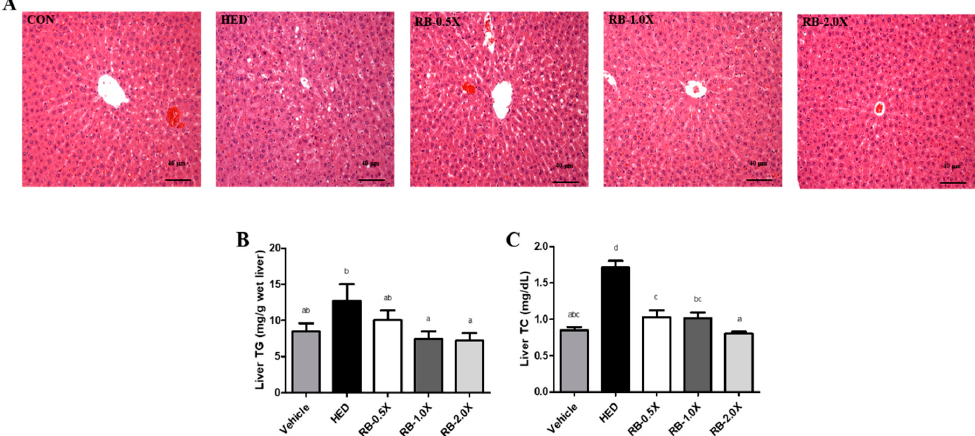
Figure 1. Effect of rice bran (RB) on the hepatic lipid accumulation in rats with high-energy diet (HED)-induced obesity. ( A ) Hematoxylin and eosin staining of liver sections (100× magnification). Scale bar: 40 μ m. ( B ) Liver triglyceride (TG) concentration and ( C ) liver total cholesterol (TC) concentration. The x-axis parameters are as follows: Vehicle, SD rat fed with chow diet; HED, SD rat fed with HED; RB-0.5X, SD rat fed with HED and RB-0.5X; RB-1.0X, SD rat fed with HED and RB-1.0X; and RB-2.0X, SD rat fed with HED and RB-2.0X. The data are expressed as the mean ± SE ( n = 10). Different letters (a, b, and c) indicated significant differences at p < 0.05 by one-way ANOVA.